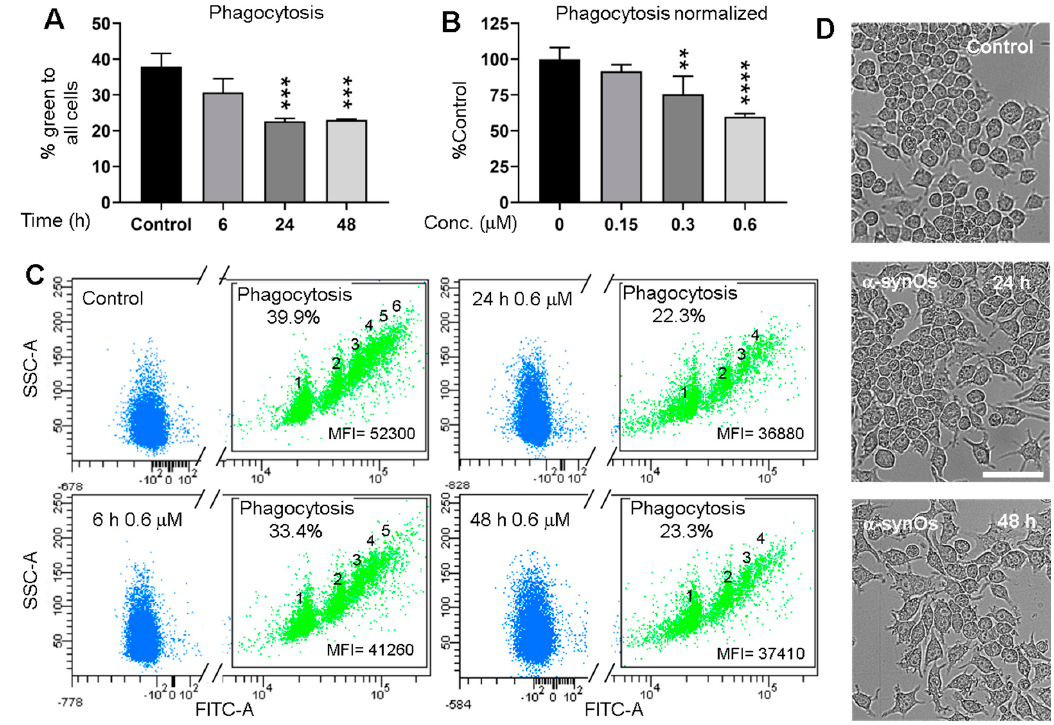
Figure 6. H- α SynOs impaired phagocytosis in MMGT microglia. ( A ) MMGT cells were exposed for different periods to 0.6 μ M α synOs or ( B ) to different doses of H- α SynOs for 24 h, and then subjected to phagocytosis assay with green fluorescent beads for 2.5 h. The percentage of green cells containing one or more phagocytosed beads was assessed by flow-cytometry and normalized ( B ), or not ( A ) to % phagocytosis in control cells. Graphs show the mean of 3 independent experiments +/- SD. **, ***, **** statistically significant differences at p < 0.05, 0.01, 0.0001 respectively, analyzed by Tukey post-hoc test. ( C ) Representative flow cytometry scatter plots showing green fluorescence (FITC) and side scatter (SSC) parameters of cells pre-treated for 6, 24, or 48 h with 0.6 μ M H-H- α SynOs, and subjected to phagocytosis assay as in A. Green populations of cells containing 1, 2, 3, up to 6 beads per cell, % green cells with respect to total events and mean fluorescence intensity (MFI) were indicated for each scatter plot. ( D ) Microphotographs of MMGT cells treated as in C, before phagocytosis assay. Bar 100 μ m. Note the different morphology of microglia in the presence of H- α SynOs.